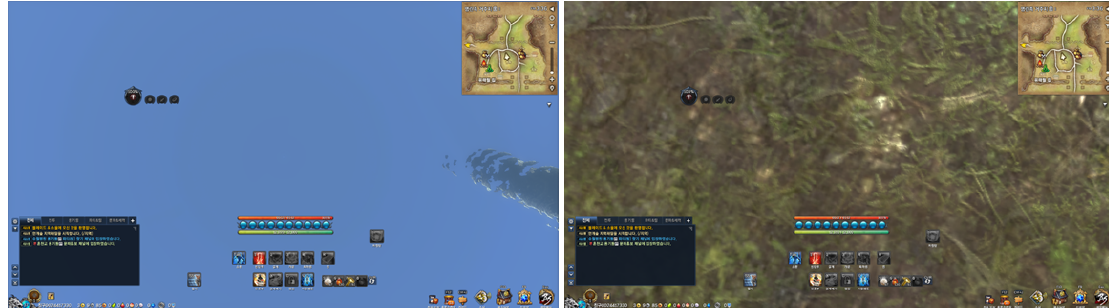
Figure 1. Two screen images captured for UI extraction.